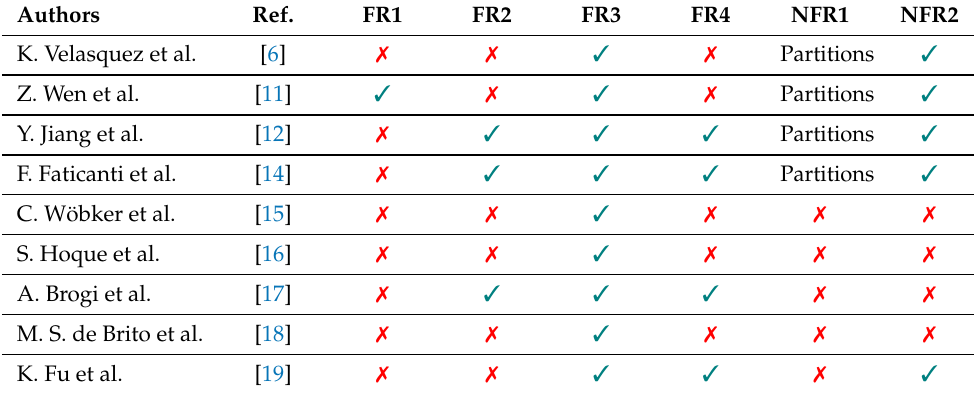
Table 1. Related work